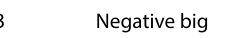
Table 3 Variation of weighting factor and related control action Sign of change of